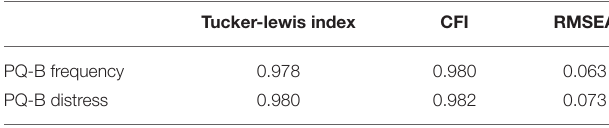
TABLE 4 | Model fit parameters for CFA performed on PQ-B frequency and distress